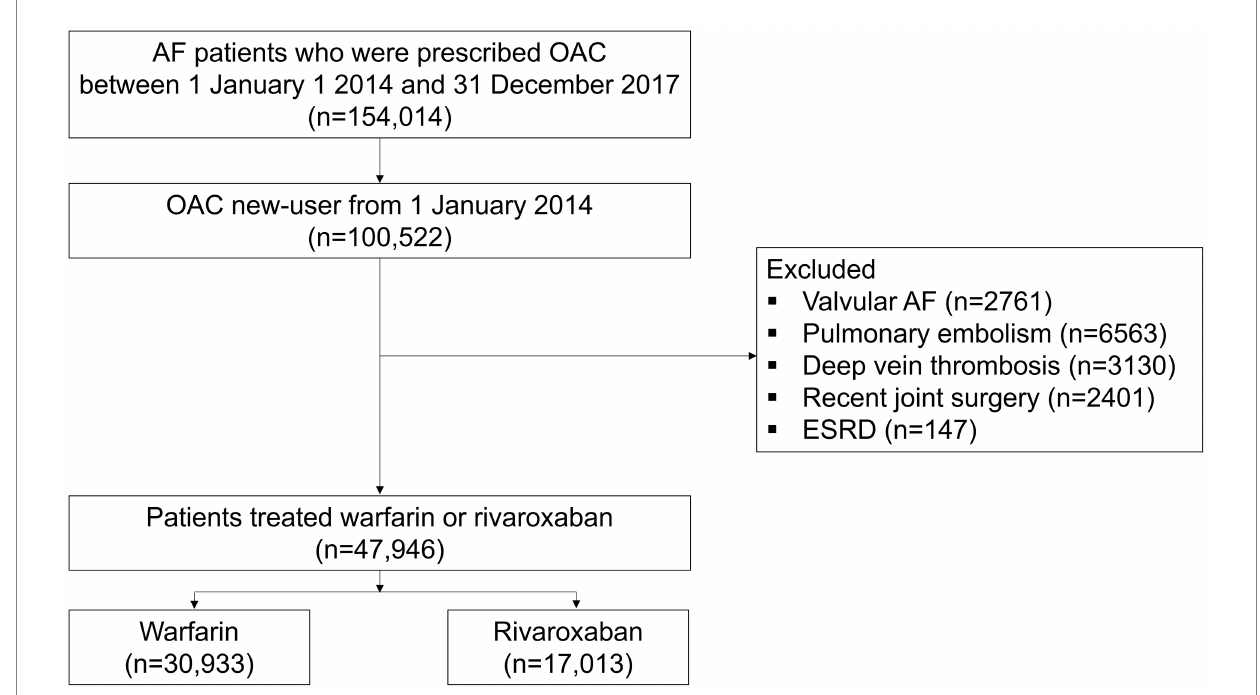
FIGURE 1 Study enrollment flow. AF, atrial fibrillation; ESRD, end-stage renal disease; OAC, oral